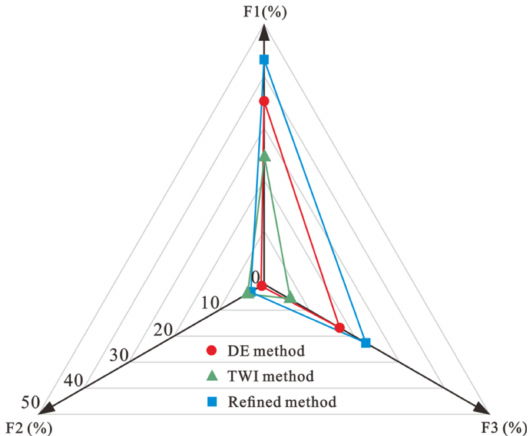
Figure 8. The three types of indicators: F1, F2 and F3 achieved by the DE, TWI and refined methods based on their optimal thresholds, respectively.